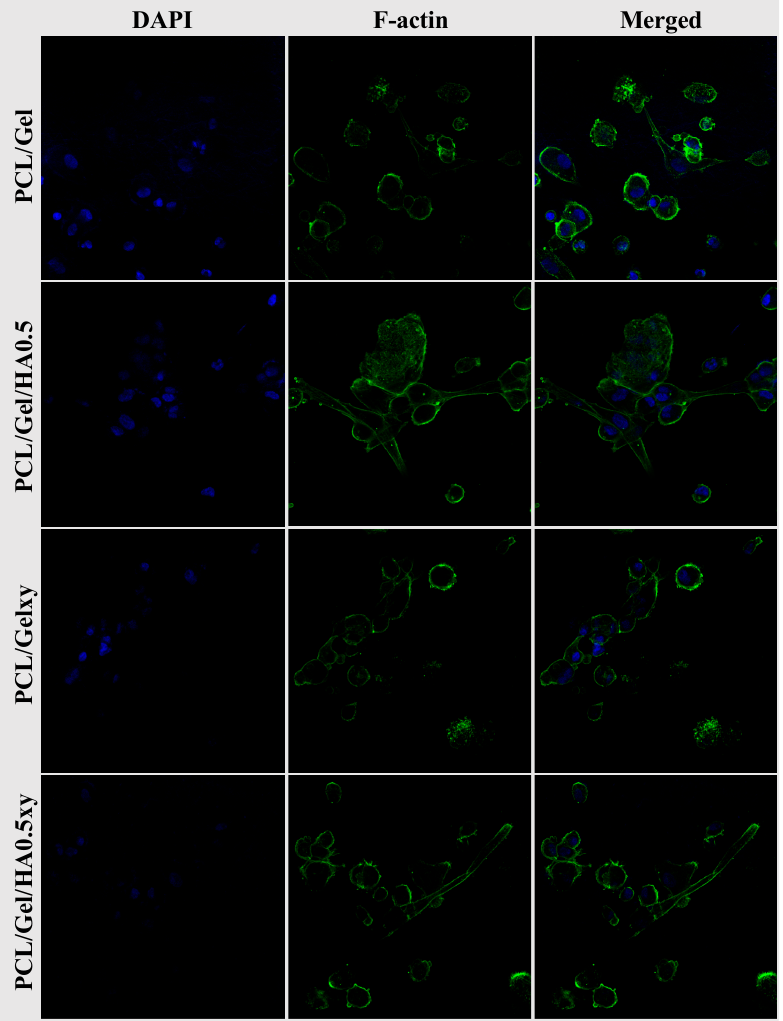
Figure 9. Confocal microscopy images of U251 cells seeded on scaffolds. Cells on scaffolds were stained with DAPI to display blue (nuclei) and F-actin to show green (cytoskeleton).